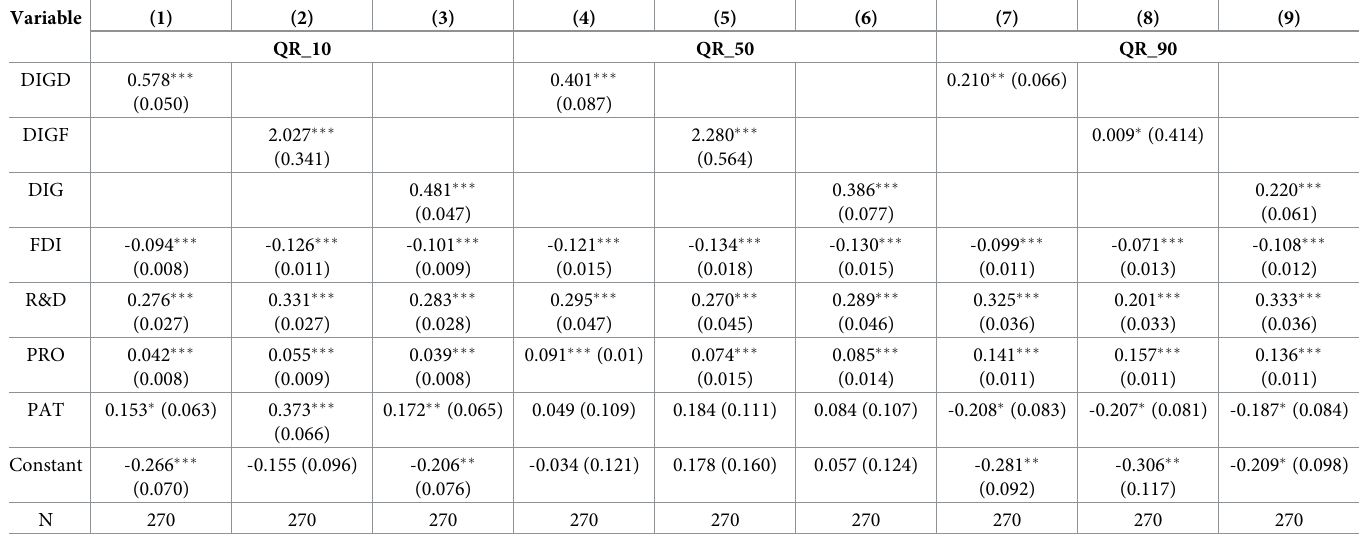
Table 5. Quantile regression